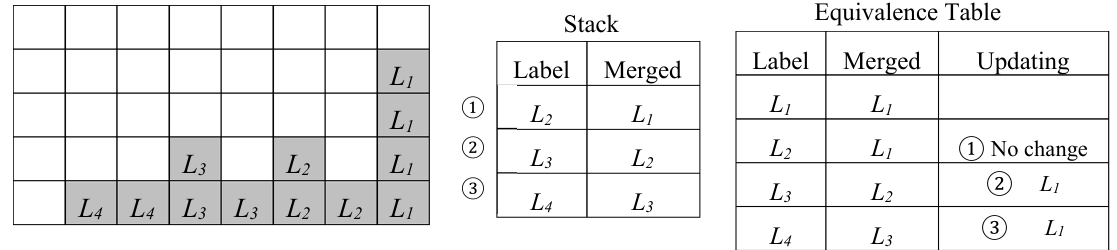
Figure 5. Example of the chain of collisions solved by the backward merging technique.